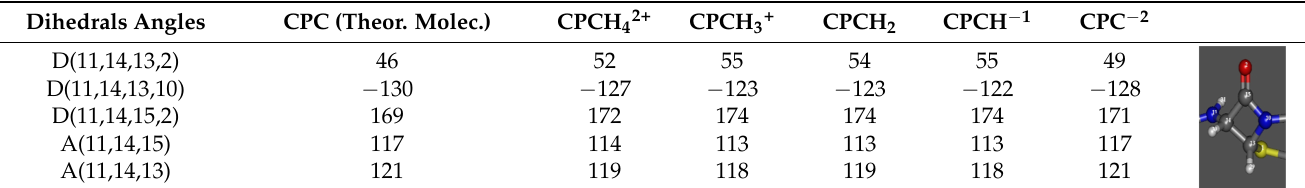
Table 1. Diedral angles of different ionizated forms of cephalosporin C.